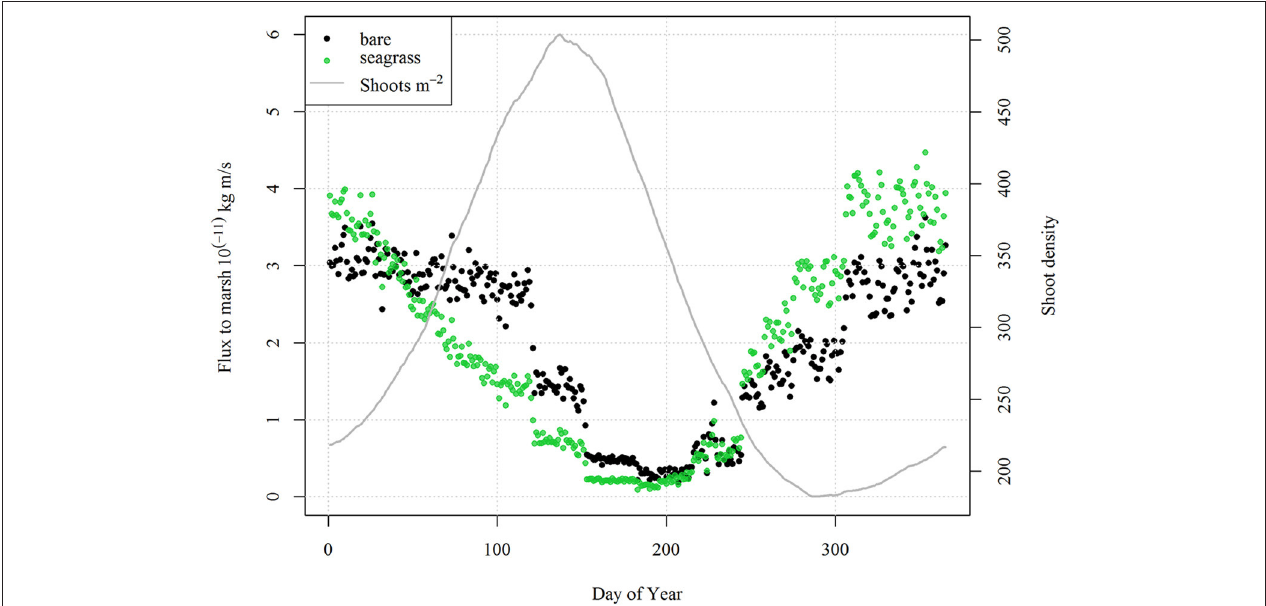
FIGURE 10 | Daily bin-averaged shoot density and daily bin-averaged scaled sediment flux ( F m d f / b f ) to the salt marsh with (green) and without seagrass (black) from 500 year-long model runs initiated with RSLR = 4mm year − 1 , Co = 30mg L − 1 and an initial tidal flat width of 4km. Note the decrease in flux during spring and early summer alongside increases in shoot density, and enhanced flux during the fall due to the seasonal seagrass